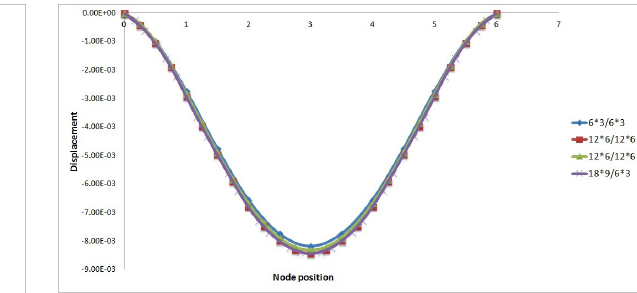
Figure 17: Transverse displacement u 3 distribution with Q4 plate el- ements using conforming and nonconforming mesh configurations.